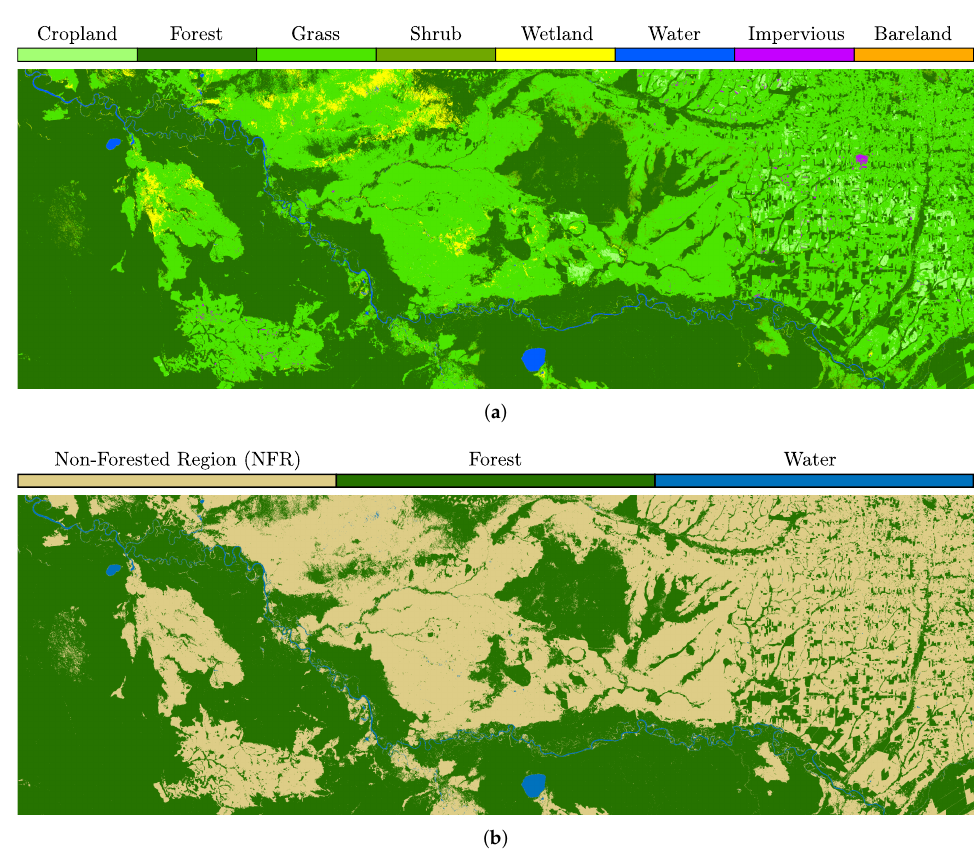
Figure 4. Cropped region from the TS4 010 swath, displaying ( a ) the highly imbalanced original eight FROM-GLC classes and ( b ) the three higher-level classes considered in this paper: Non-Forested Region (NFR), Forest, and